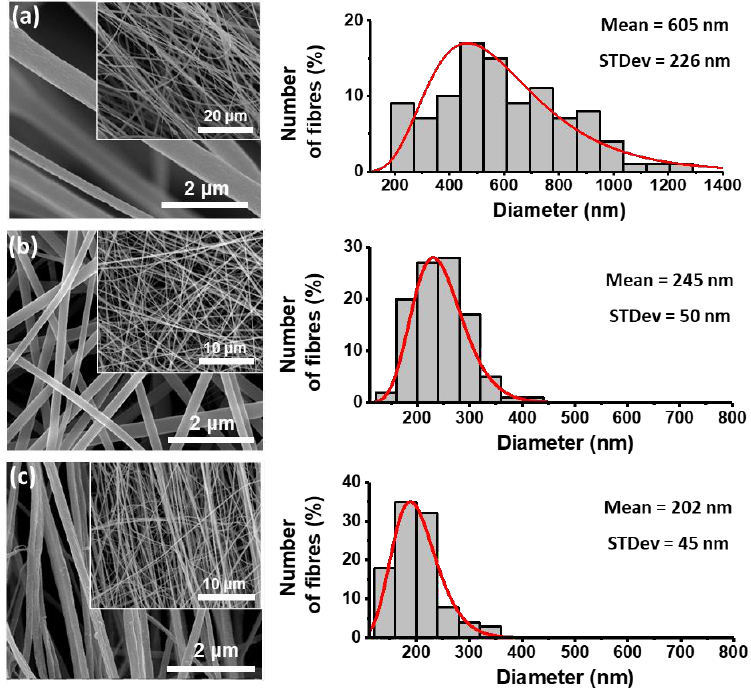
Figure 5. SEM images at magnification levels of 10,000 × and 50,000 × and respective fiber diameter distribution histograms for PMMA ( a ), PA66 ( b ), and PVC ( c ) nanofibers with embedded MDABCO-NH 4 I 3 perovskite crystals. The red curves indicate logarithmic normal distributions using the mean and standard deviations of each set of fibers.